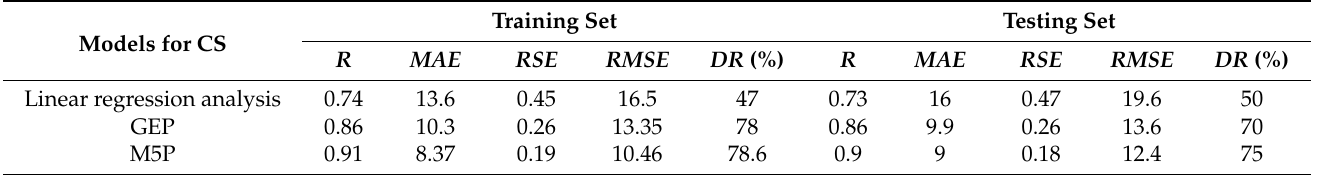
Figure 6. Comparison of the linear regression analysis, GEP, and M5P for the prediction of the CS of concrete made with SF: ( a ) training dataset; ( b ) testing dataset. Table 4. Comparison of the different models developed for the CS database.